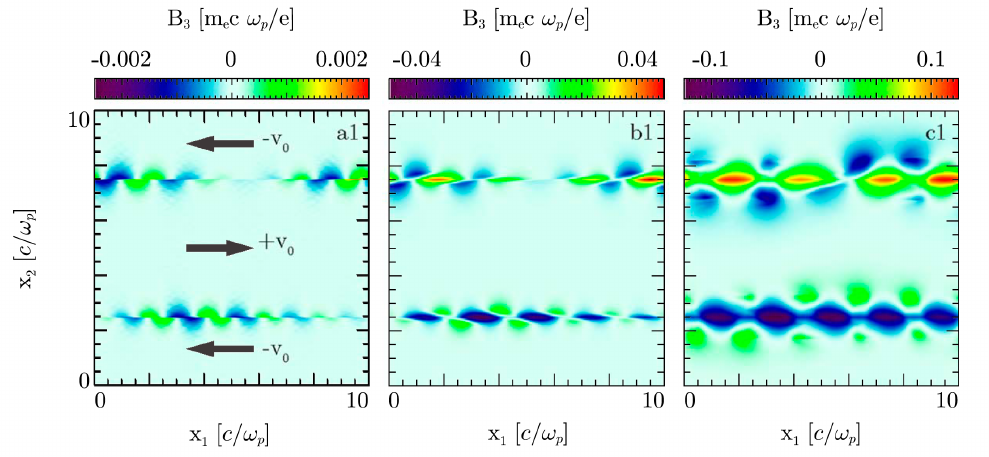
Figure 2. Results of two-dimensional PIC simulations of counter-propagating flows of equal density ( n + = n − ) and with | v 0 | = 0.2 c, showing the emergence of a dominant DC ( k 1 = 0 ) magnetic field component along the shear on top of the harmonic structure inferred from the linear fluid regime at times ω pe t = 35 (a1), 45 (b1) and 55 (c1). From Ref.